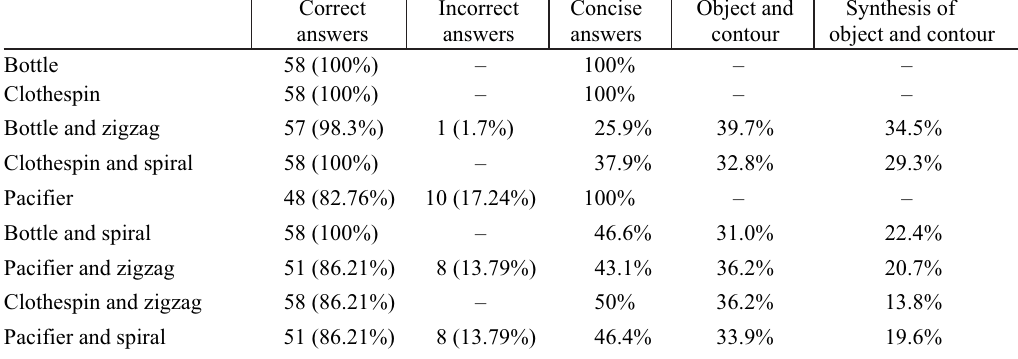
Table 1. Results of the visual­perception